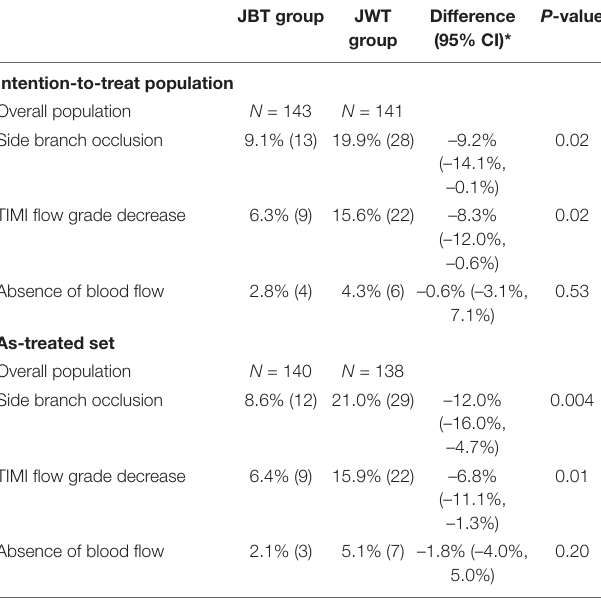
TABLE 4 | Primary endpoint (intention-to-treat and as-treated